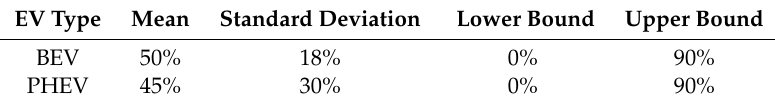
Table 2. Coefficients describing the assignment of EV battery states of charge on